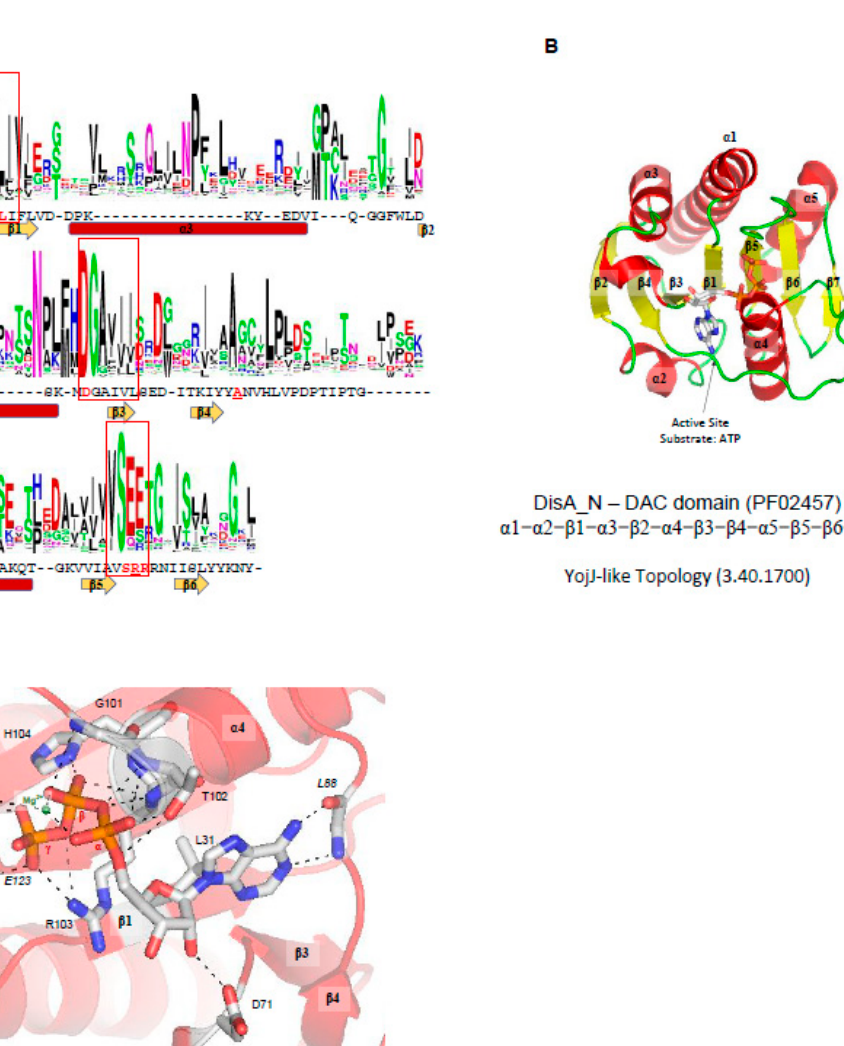
Figure 6. Conserved sequences within DAC domain members and its substrate binding pocket. ( A ) residue frequency present in DAC proteins. In addition, 609 sequences were used from the Pfam database to create a multiple sequence alignment of the DAC domain of different proteins using ClustalW [116], and the sequence logo was done using the WebLogo server [90]. The sequence shown below the logo and the secondary structure elements belong to the DisA protein from T. maritima (PDBID: 3C1Y). Residues that bind ATP or the magnesium cation are colored in red, underlined residues bind mainly by the main chain. Conserved motifs within DAC members are placed in red boxes: GALI, DGAhh, GxRHRxA, and (V / I)SEE motifs. ( B ) structure of the DAC domain of CdaA from Listeria monocytogenes (PDBID: 4RV7). The substrate ATP is found bound at the active site. The DAC domain topology is shown below the structure, and the CATH topology name and code are also shown [91]; ( C ) interaction network between the CdaA binding pocket with the substrate, ATP (PDBID: 4RV7). Gray dotted lines represent hydrogen bonds, the magnesium ion is colored in green, and the ATP and the protein residues involved in its binding are shown as sticks. Carbons are colored white, oxygens are red, nitrogen atoms are blue, and phosphorous atoms are orange.